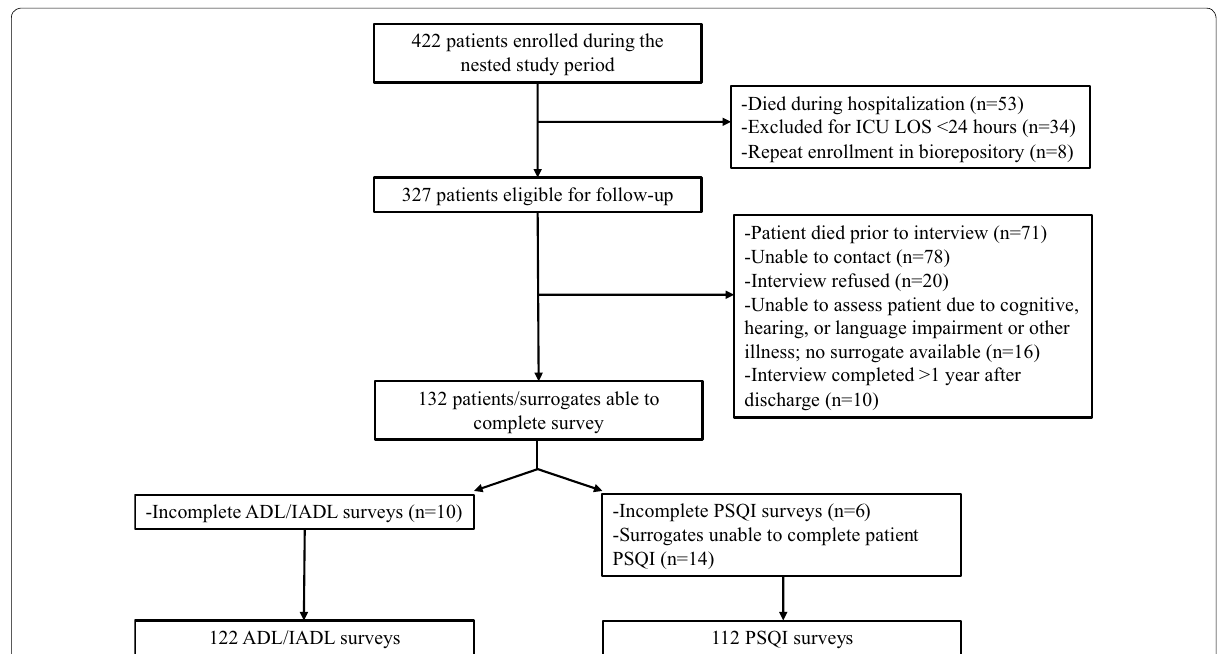
Fig. 1 Consort diagram for cohort development, ADL activities of daily living, IADL instrumental activities of daily living, ICU intensive care unit, LOS length of stay, PSQI Pittsburgh Sleep Quality